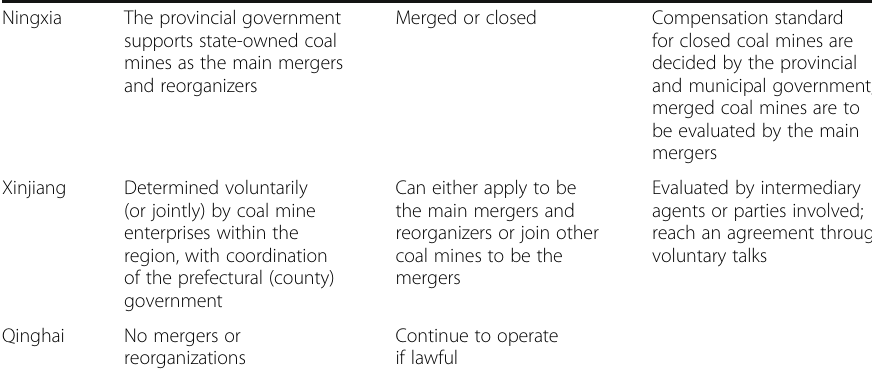
Table 2 Basic features of the mergers and reorganizations policy for each province (including autonomous regions and municipalities)